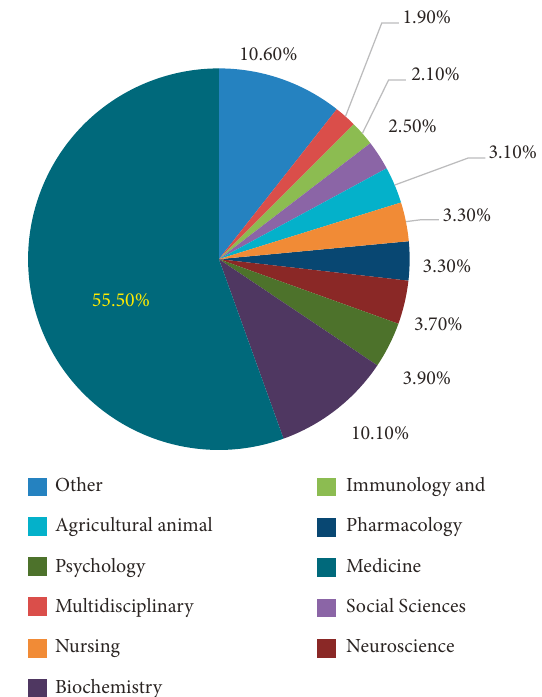
Figure 25: Pie chart depicting article distribution by disciplines for meta-analysis articles.